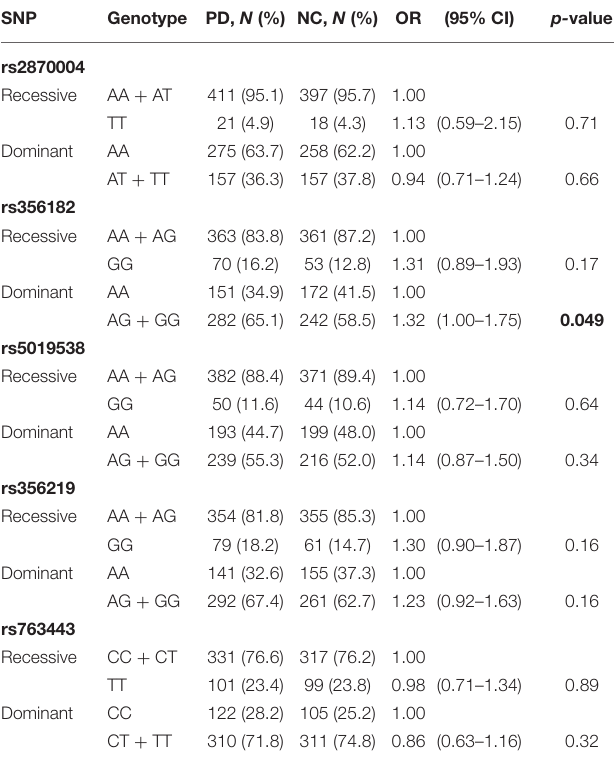
TABLE 2 | Comparison of genotypes of each SNCA variant between PD patients and